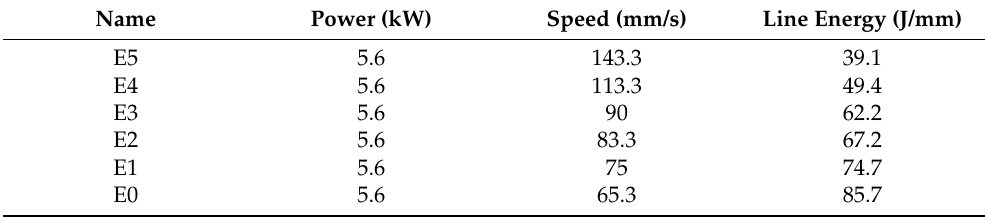
Table 5. Overview of welding speeds and line energies used for welding depth studies with steel A.